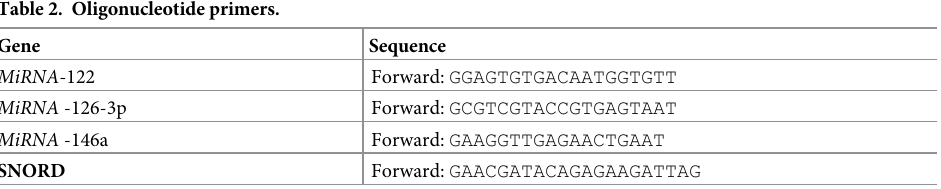
Table 2. Oligonucleotide primers.